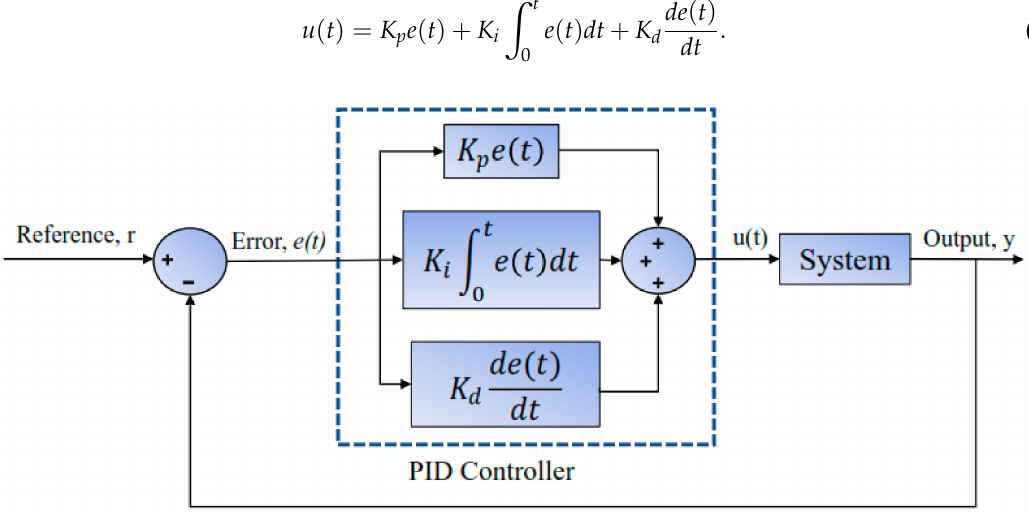
Figure 5. A typical block diagram of a proportional–integral–derivative (PID) controller with feedback